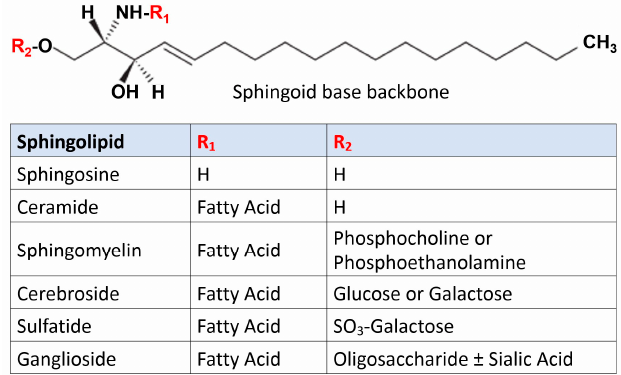
Figure 1. Schematic structure of sphingolipids.